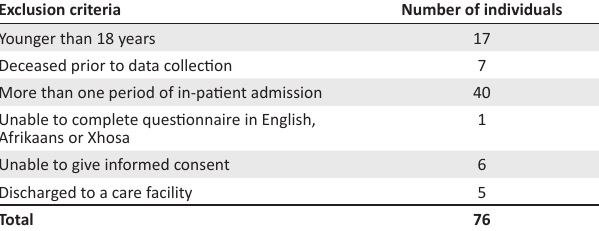
TABLE 1: Number of persons excluded based on exclusion criteria. Exclusion criteria